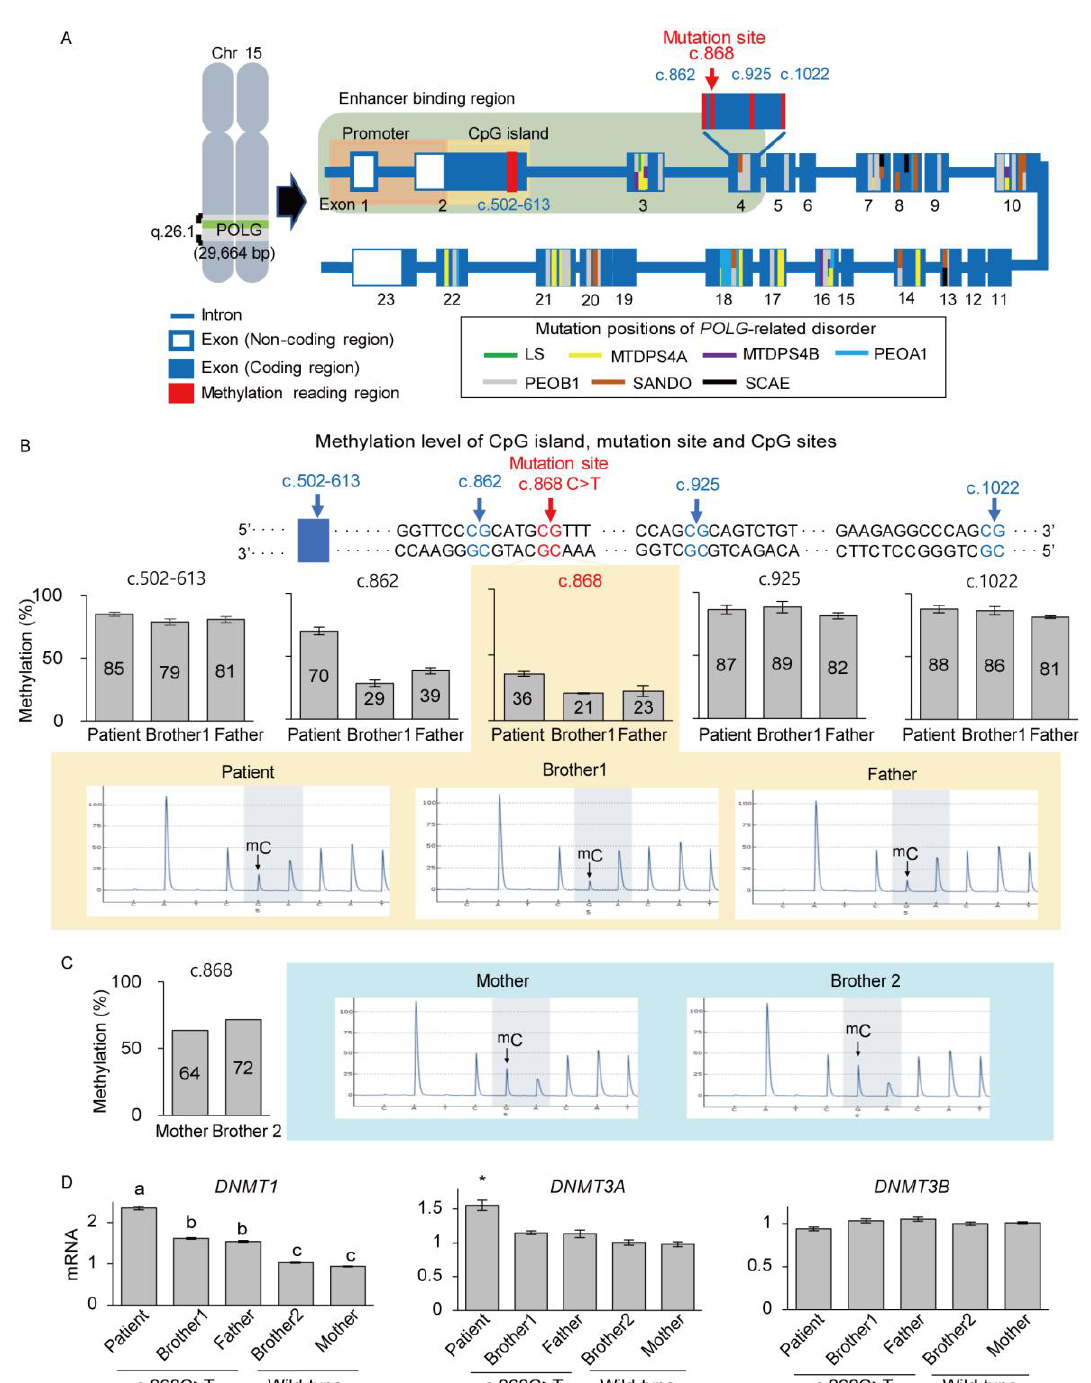
Figure 5. Hypermethylation of c.868 in the POLG gene of the PS patient. ( A ) Schematic of the mutation positions of POLG -related disorders and methylation readings for various regions of the POLG gene. LS, Leigh syndrome; MTDPS4A, mitochondrial DNA depletion syndrome 4A; MTDPS4B, mitochondrial DNA depletion syndrome 4B; PEOA1, progressive external ophthalmoplegia with mitochondrial DNA deletions, autosomal dominant 1; PEOA2, progressive external oph- thalmoplegia with mitochondrial DNA deletions, autosomal dominant 2; SANDO, sensory ataxic neuropathy dysarthria and ophthalmoparesis; SCAE, spinocerebellar ataxia with epilepsy. ( B ) The methylation status of CpG islands (c.502–613), mutation position (c.868), and CpG sites (c.862, c.925, and c.1022) are located close to the mutation position in the PS patient, brother 1, and the father. c.862 and c.868 were hypermethylated in the PS patient, while the CpG island and other CpG sites were comparable to those of the wild type. Only the wild-type allele at c.868 could be methylated, with the pyrosequencing results confirming no methylation at the mutated allele at c.868. m C in the pyrosequencing peak map represents a methylated cytosine. Each assay was completed in duplicate, and samples were collected from individual cell